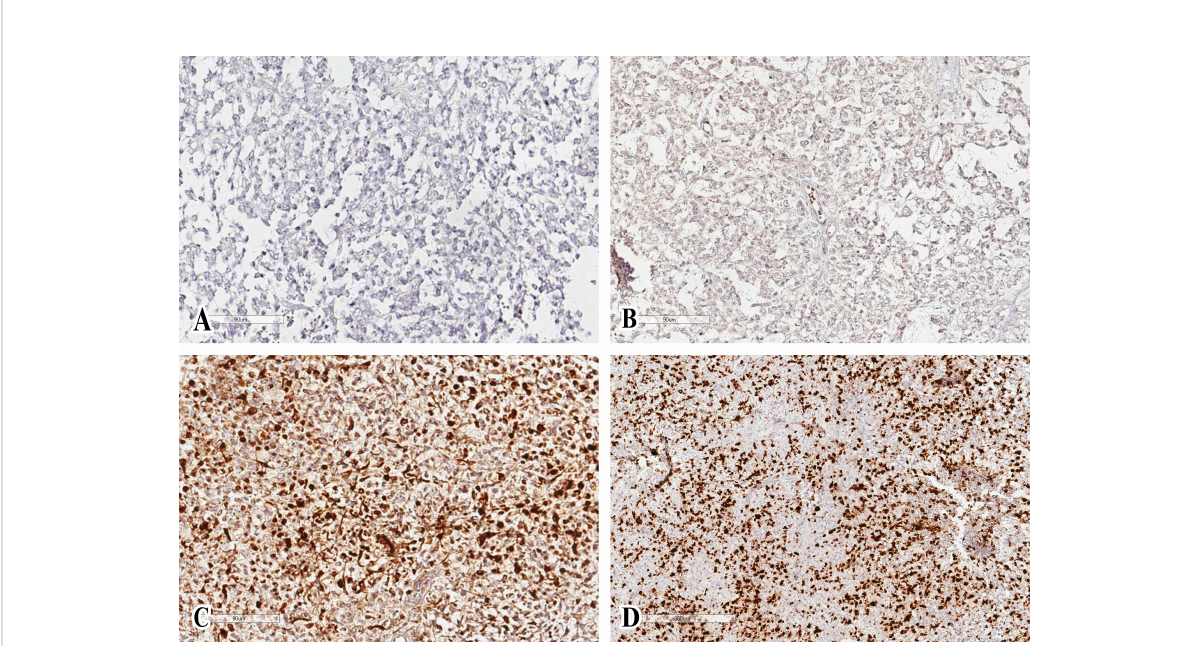
FIGURE 2 Histologic specimen with features consistent with atypical teratoid/rhabdoid tumor. Glial fi brillary acidic protein (A) and epithelial membrane antigen (B) immunochemistry demonstrates diffuse positivity. Cytokeratin AE1/AE3 (C) was not positive in tumor cells. The proliferative activity of tumor cells is high, the Ki-67 index is 40-50% (D)